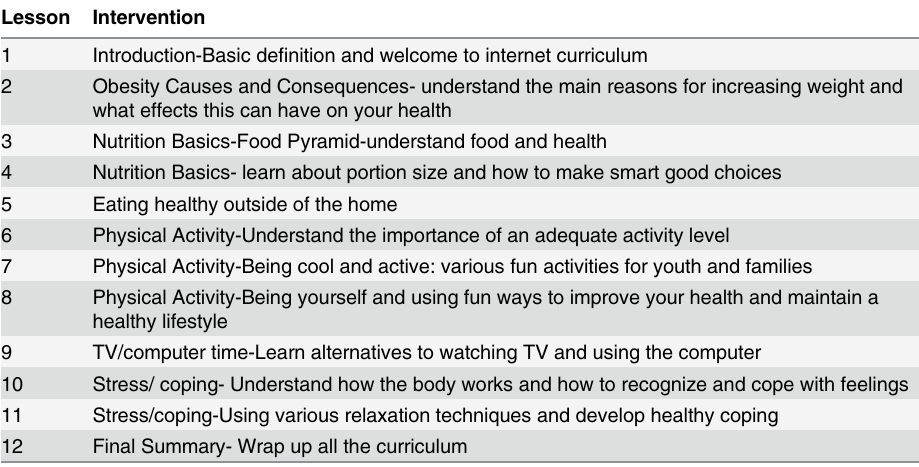
Table 1. 12-week internet based